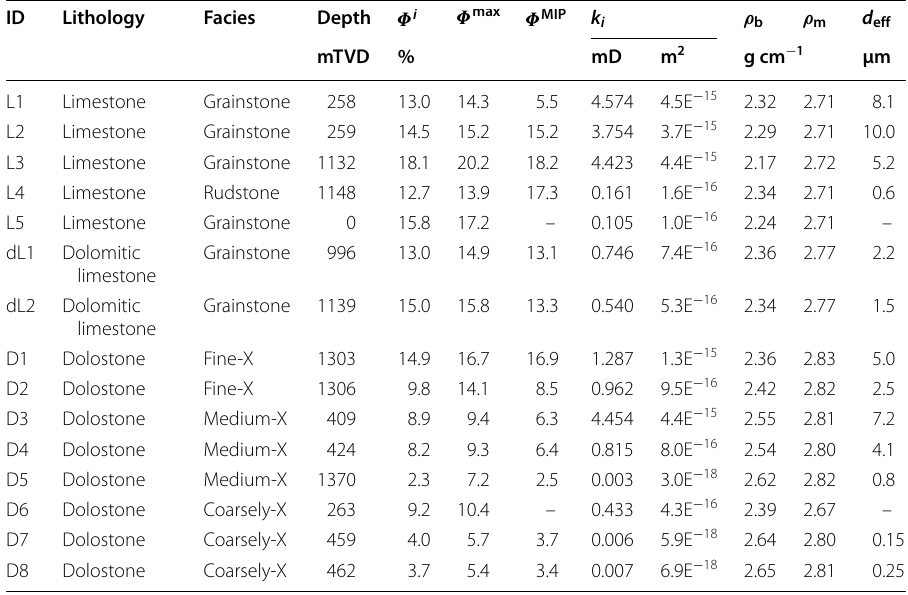
Φ i effective porosity for water, Φ max maximum effective porosity for helium, Φ MIP effective porosity by mercury injection, k i initial permeability, ρ b bulk density, ρ m particle density, d eff effective pore throat diameter, X